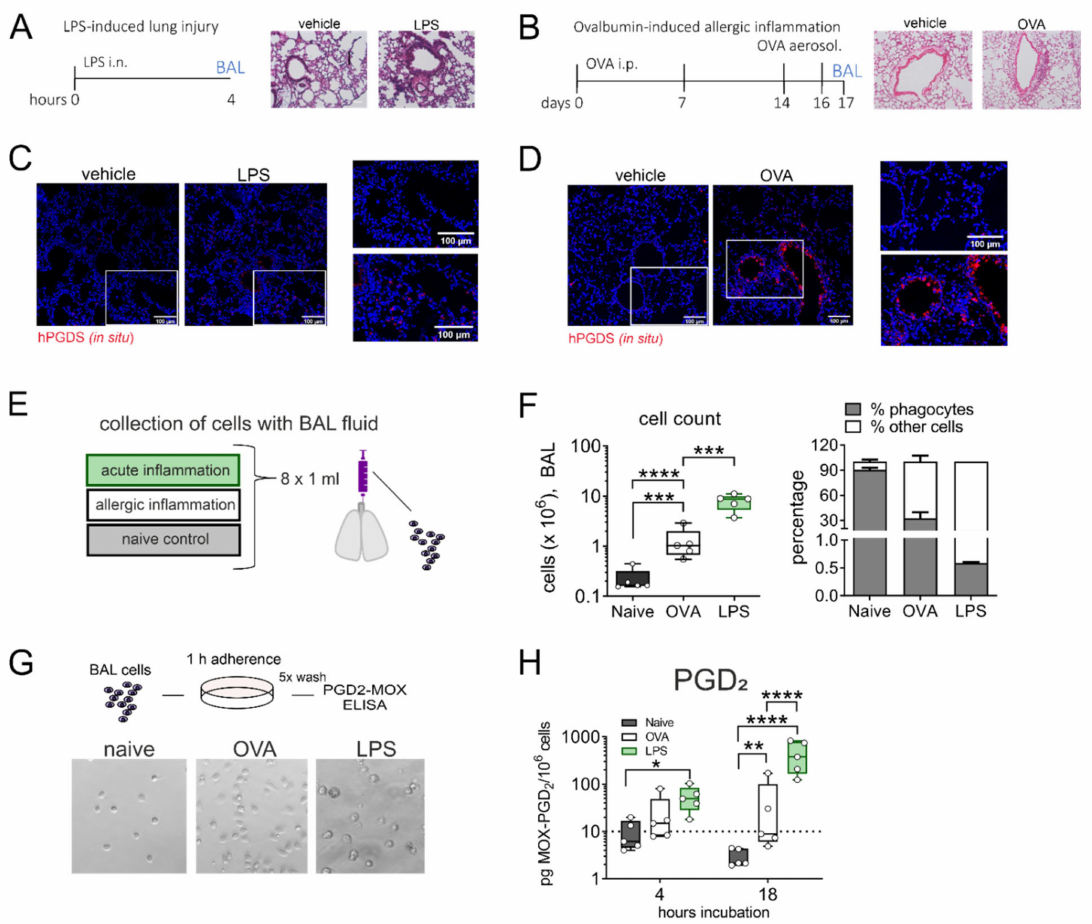
Figure 3. Alveolar monocytes/macrophages from LPS- but not OVA-challenged mouse lungs release high amounts of PGD 2 . ( A ) Experimental protocol of LPS-induced lung inflammation and ( B ) OVA-induced allergic inflammation in BALBc mice. Lung histology for both pulmonary inflammation models are shown (H&E staining, representative of 3 mice each). ( C , D ) In both inflammatory models, hPGDS mRNA was notably upregulated (representative of 3 mice, scale bar 100 µ m). ( E ) Alveolar cells were collected by broncho-alveolar lavage (BAL) at indicated time points. ( F ) BAL fluid from LPS-induced lung inflammation and OVA-induced allergic inflammation showed a characteristic (granulocytic) infiltration. The percentage of mononuclear phagocytes in BALF was estimated by morphological differences. ( G ) BAL cells were seeded into CellBind plates and non-adherent cells washed off after 1 h adherence. Enriched adherent phagocytes were incubated for indicated time points. Representative images of obtained populations are shown. ( H ) Mononuclear phagocytes from LPS-induced lung inflammation released significantly more PGD 2 after 18 h in culture. Data are shown as bar chart + SEM or box-and-whisker plot, n = 5. One-way ANOVA with Tukey‘s post hoc test (log-transformed) ( F ) or two-way ANOVA with Tukey’s post hoc test (log-transformed) (H), * p < 0.05, ** p < 0.01, *** p < 0.001, **** p <